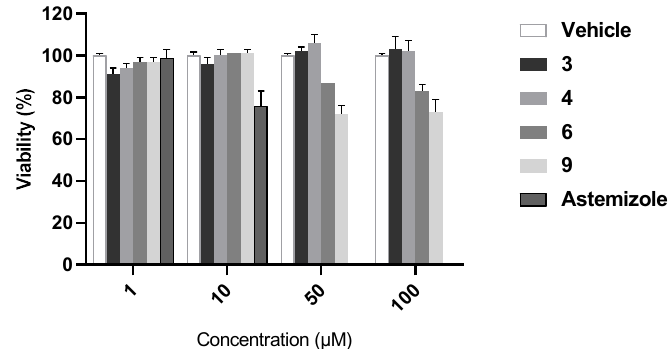
Figure 5. Viability of HepG2 cells incubated in the presence of compounds 3, 4, 6, 9 and astemizole at concentration range 1–100 μM for 24 h. The graph show results from PrestoBlue assay expressed as the percentage of control condition ± SEM. Three independent experiments were performed.